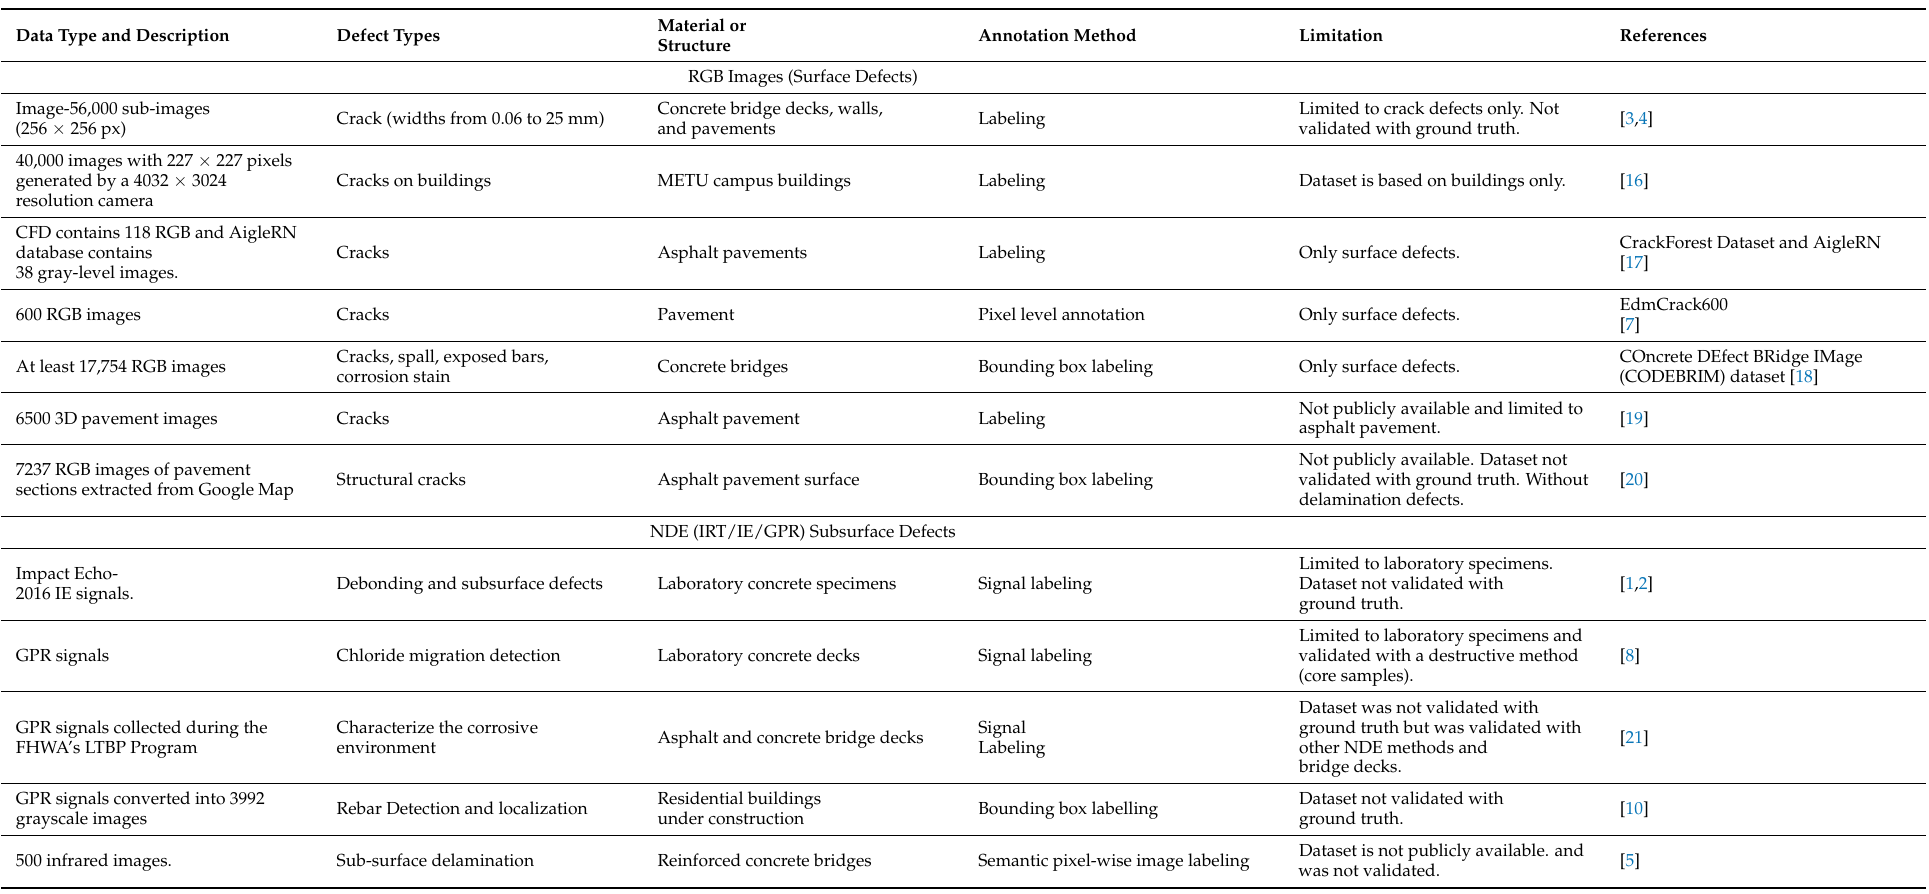
Table 1. Available open-source